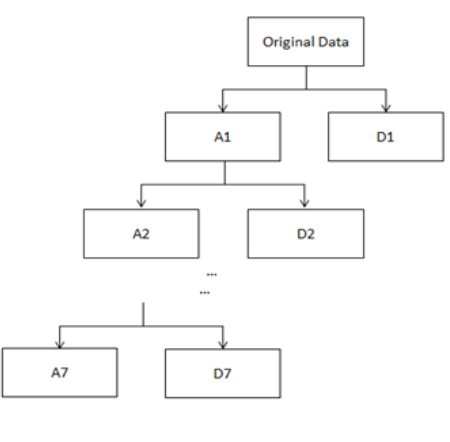
Figure 2. Decomposition